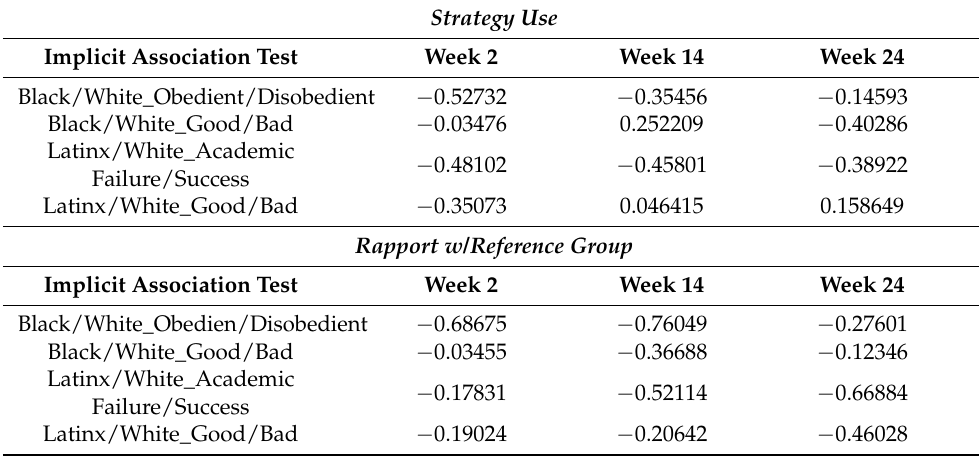
Table 3. Correlation Coefficients for Cross-Sectional Relationships between Strategies Use and IAT D Scores and Rapport and IAT D